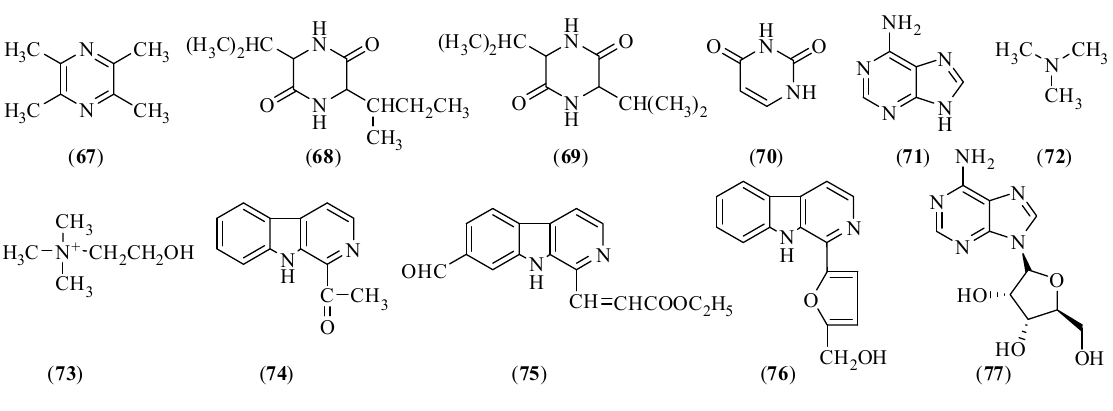
Figure 3. Chemical structures of main alkaloids in CX: ( 67 )